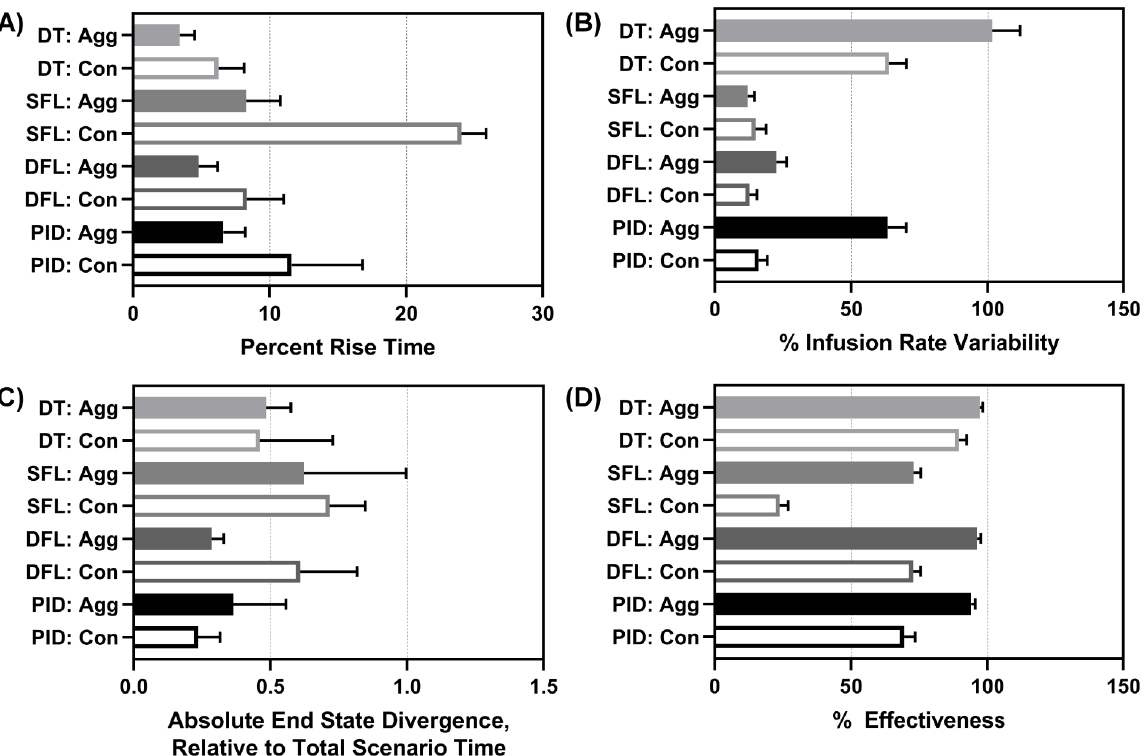
Figure 7. Average performance metrics results. Mean performance results for each controller type (DT = decision table; SFL = single-input fuzzy logic; DFL = dual-input fuzzy logic; PID = proportional–integral–derivative controller) and configuration (Agg = aggressive; Con = conservative) for ( A ) percent rise time (lower is better), ( B ) infusion rate variability (lower is better), ( C ) end-state divergence (lower is better), and ( D ) effectiveness (higher is better). Average results are shown for three subject variability runs. Error bars denote the standard deviation.